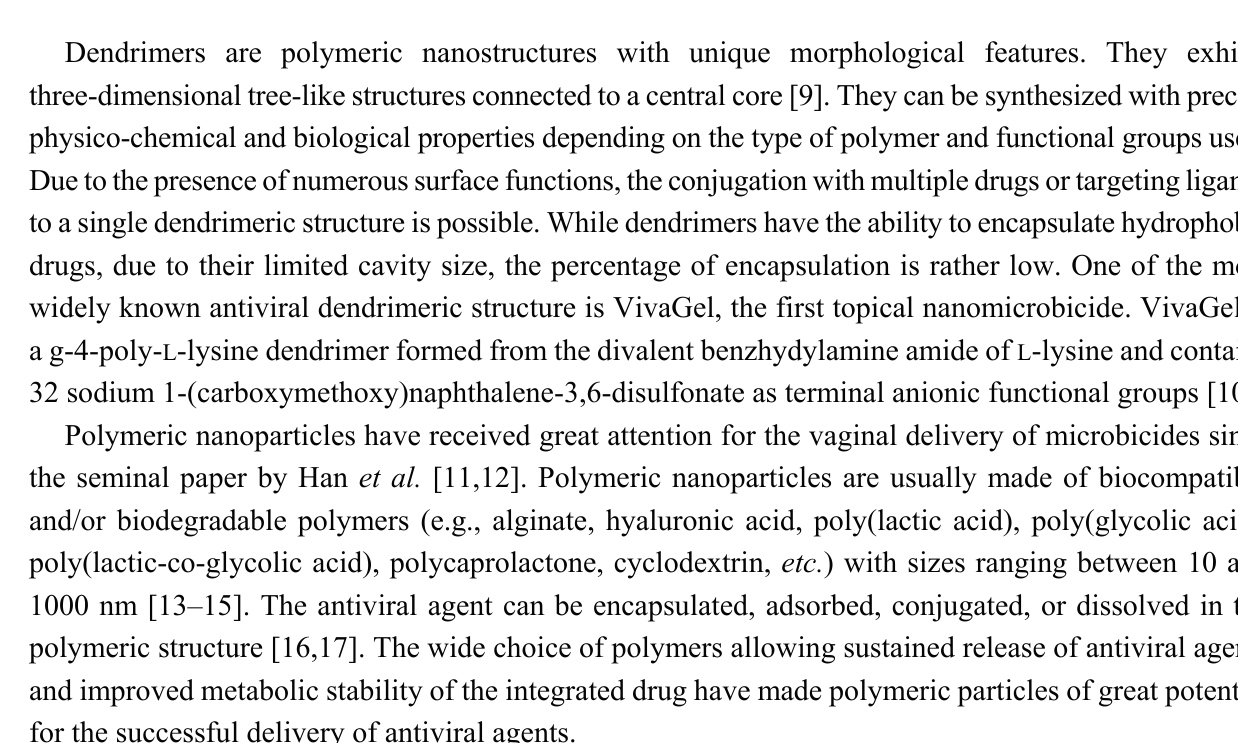
Figure 1. Different types of nanocarriers available for incorporating antiviral